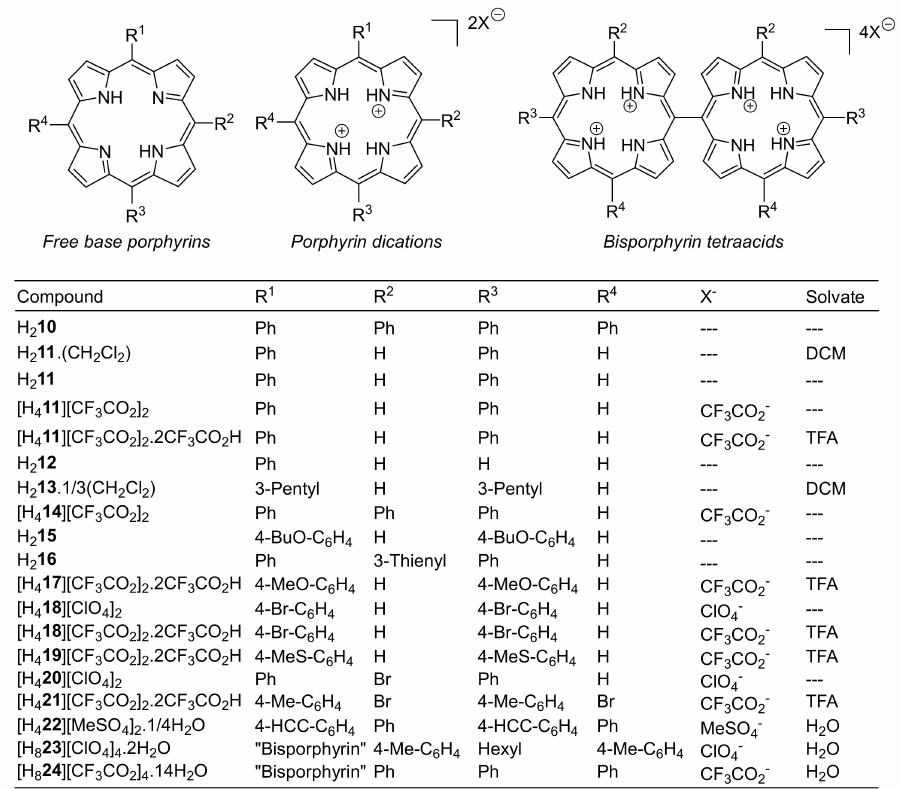
Figure 2. Porphyrins and crystal modifications studied